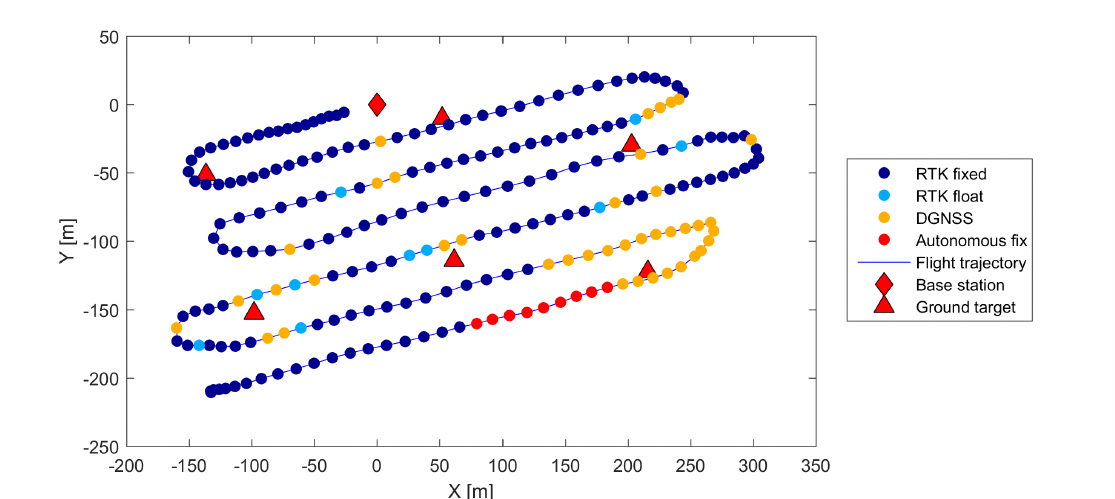
Figure 11. The camera locations and the GNSS quality indicator estimated by the onboard GNSS/INS.